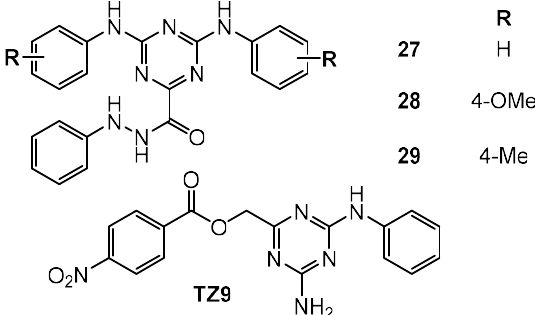
Figure 8. Structure of ubiquitin conjugating enzyme inhibitors.